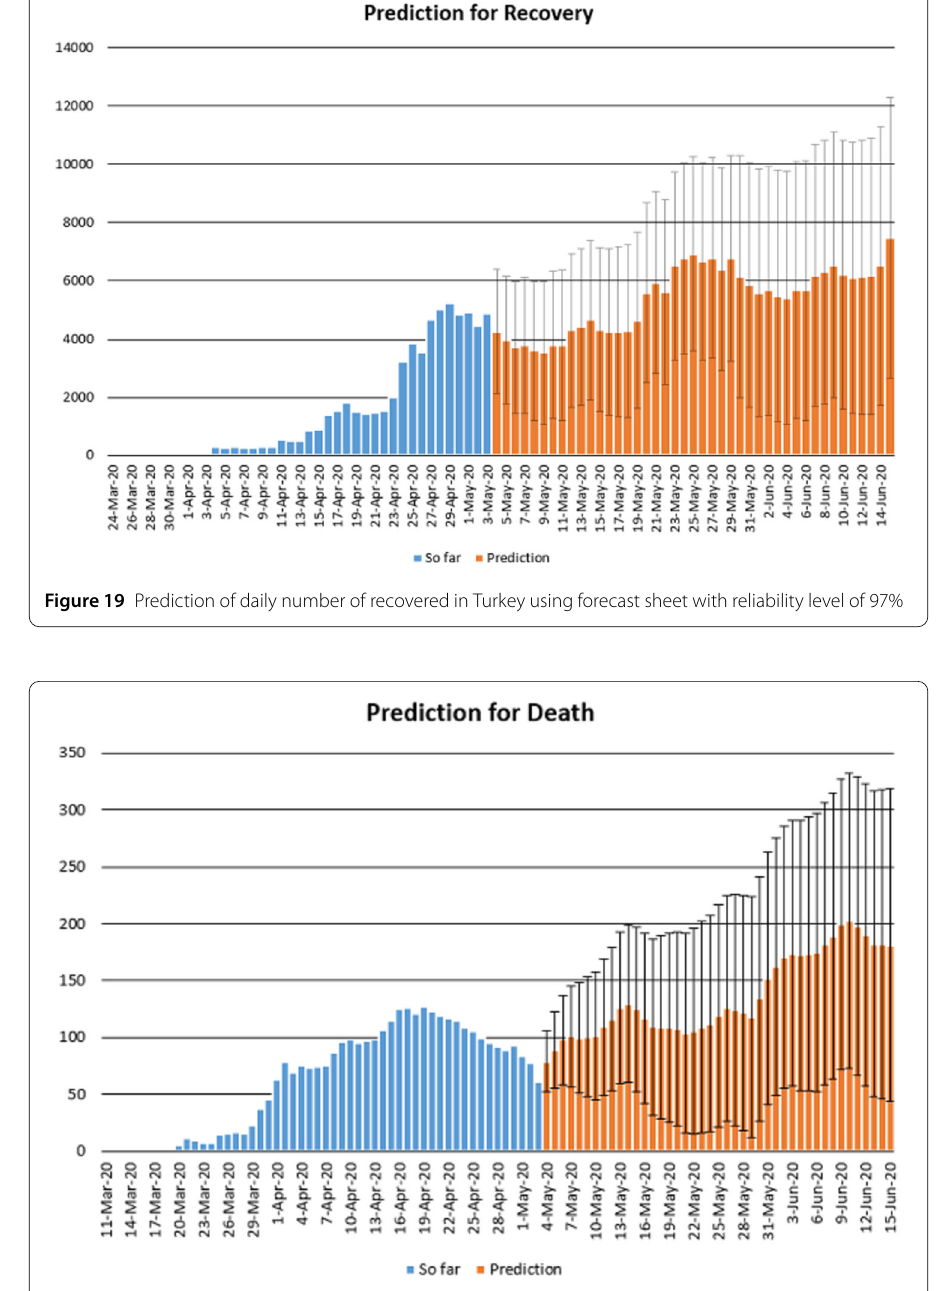
Figure 20 Prediction of daily number of dead in Turkey using Forecast Sheet with reliability level of